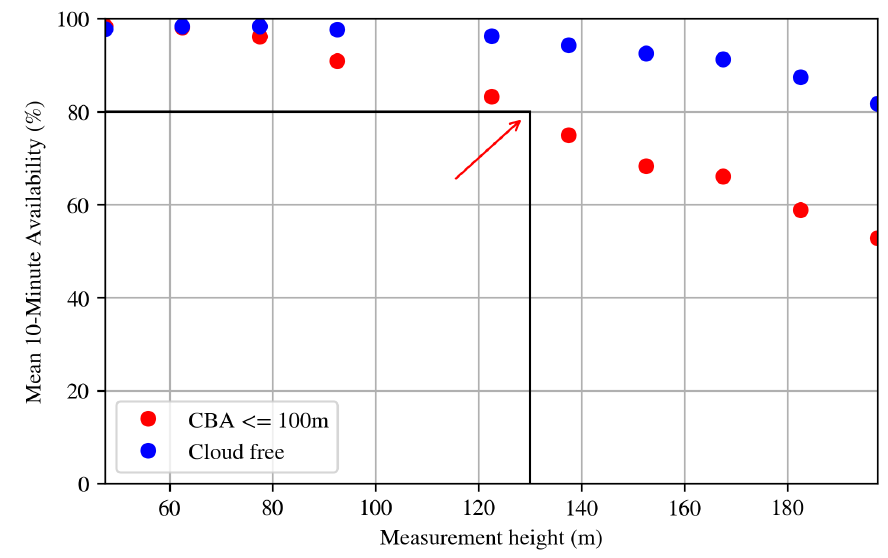
Figure 4. Mean 10-min availability on lidar measurement height above ground for cloud-free cases and situations with cloud base altitudes ≤ 100m. The red arrow marks the measurement height at which 10-min availability is below the 80% threshold in the cloud base altitudes (CBA) ≤ 100m